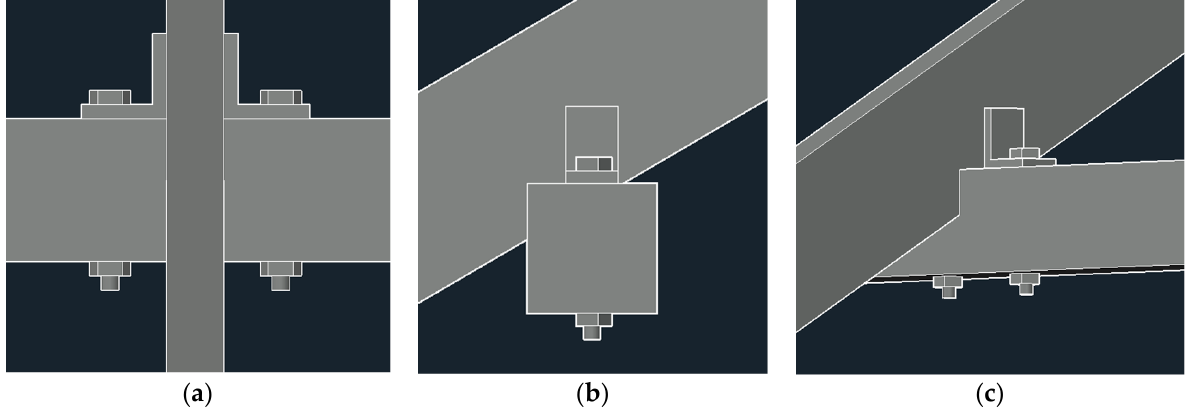
Figure 15. Scheme of rafter support on the wall: ( a ) front view, ( b ) side view, ( c ) 3D view. At the beginning, the possibility of cutting wooden elements was checked, taking into account the weakening of the